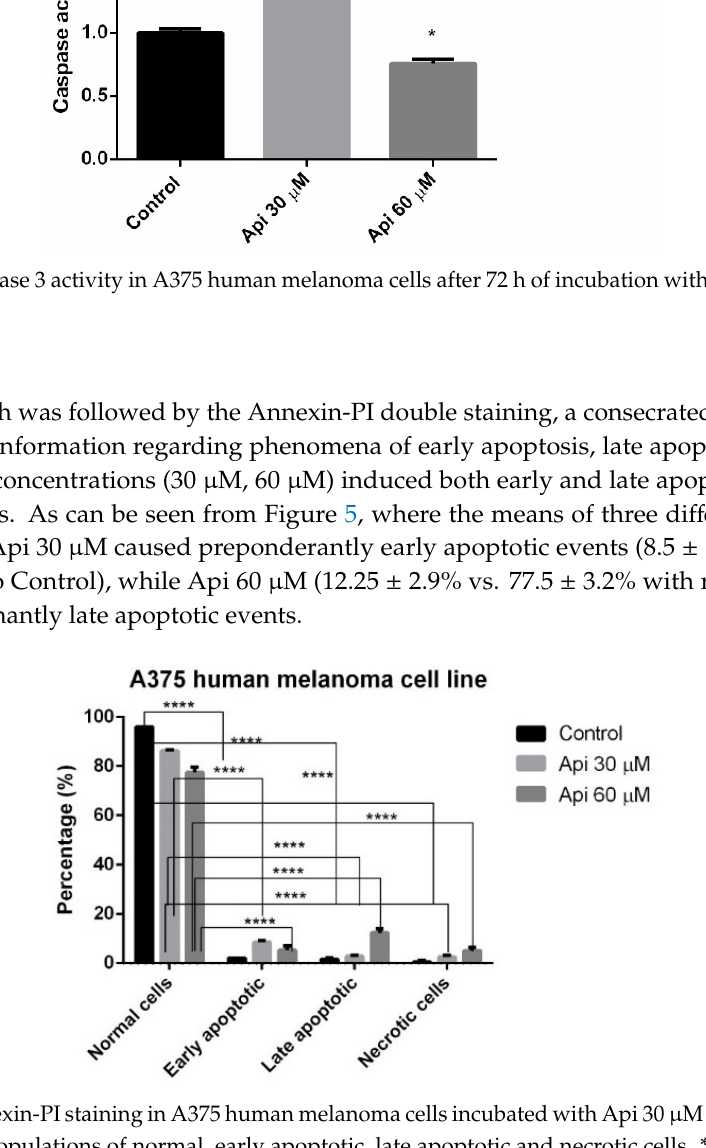
Figure 6. The cytotoxic effect of Api and DMSO at 30 μ M and 60 μ M concentrations on the human melanoma A375 cell line after 72 h exposure time. 3.7. Bioenergetic Profile of A375 Human Melanoma Cells Within this study we also assessed the Api effect on cellular bioenergetics in A375 human melanoma cells. The oxygen consumption rate (OCR) and extracellular acidification rate (ECAR) were measured at 72 h post-treatment of A375 human melanoma cells with two concentrations of Api (30 and 60 μ M) using the Seahorse XFe24 (Seahorse Agilent) extracellular flux analyser. Results describing the bioenergetic profile of A375 human melanoma cells at 72 h post-stimulation are presented in Figure 7.